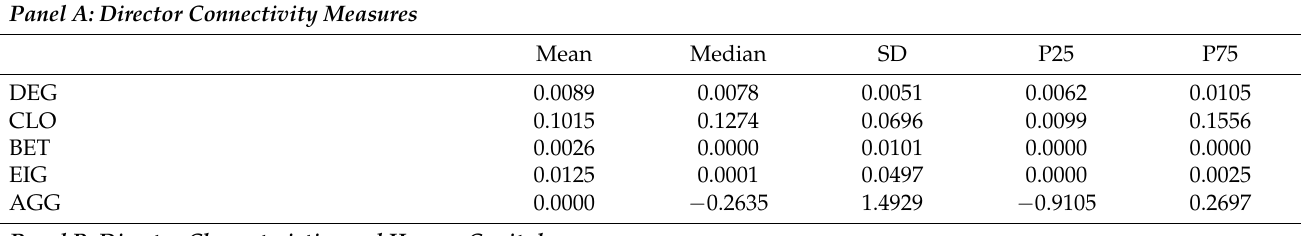
Table 1. Descriptive statistics of director human capital and social capital